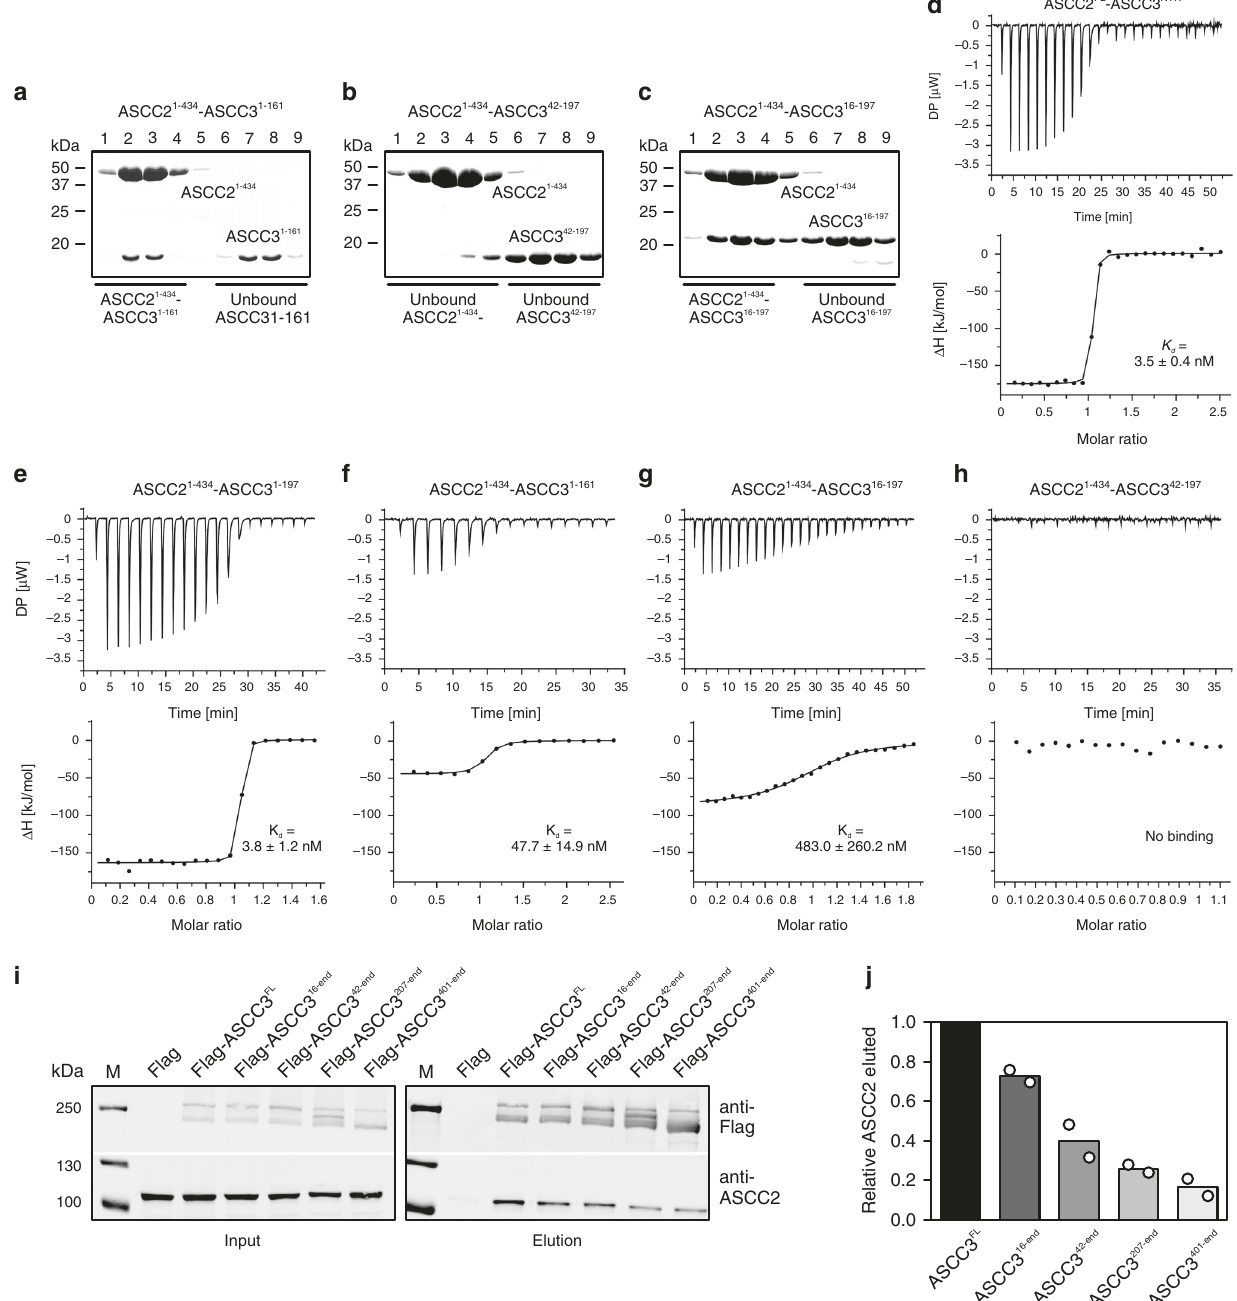
Fig. 3 Interaction analysis. a – c SDS-PAGE analysis monitoring SEC runs of the indicated mixtures of proteins. d – h ITC runs monitoring the interaction between the indicated pairs of proteins. Deduced K d values are listed as means ± SD for runs for which af fi nities could be quanti fi ed. i Western blot monitoring pulldown of ASCC2 by the indicated ASCC3 constructs from cell extracts. j Quanti fi cation of the data shown in i . Columns represent means relative to ASCC3 FL of n = 2 independent experiments, using the same biochemical samples. Open circles, individual measurements. ef fi ciently unwound a DNA duplex with 3 ’ -single stranded cores (Fig. 6a). In particular, a lysine in motif I is required for overhang, but not a duplex with 5 ’ -single stranded overhang ATP binding, while an aspartate in motif II is crucial for (Fig. 5d), and preferentially used ATP for DNA unwinding coordinating a magnesium ion to trigger the hydrolysis of ATP (Fig. 5e). Surprisingly, however, in our hands, ASCC3 NC also (Fig. 6a), and substitutions of these residues are expected to exhibited helicase activity, albeit reduced compared to ASCC3 HR strongly interfere with helicase activity. To further test (Fig. 5f). These fi ndings were con fi rmed using gel-based the contributions of the N-terminal and C-terminal cassettes to unwinding assays (Supplementary Fig. 2). the helicase activity of a dual-cassette ASCC3 construct, we Nucleic acid helicases contain a number of conserved, individually substituted the corresponding lysine and aspartate functionally important sequence motifs in their RecA domain residues in the N-terminal cassette (K505, D611), in the NATURE COMMUNICATIONS| (2020) 11:5535